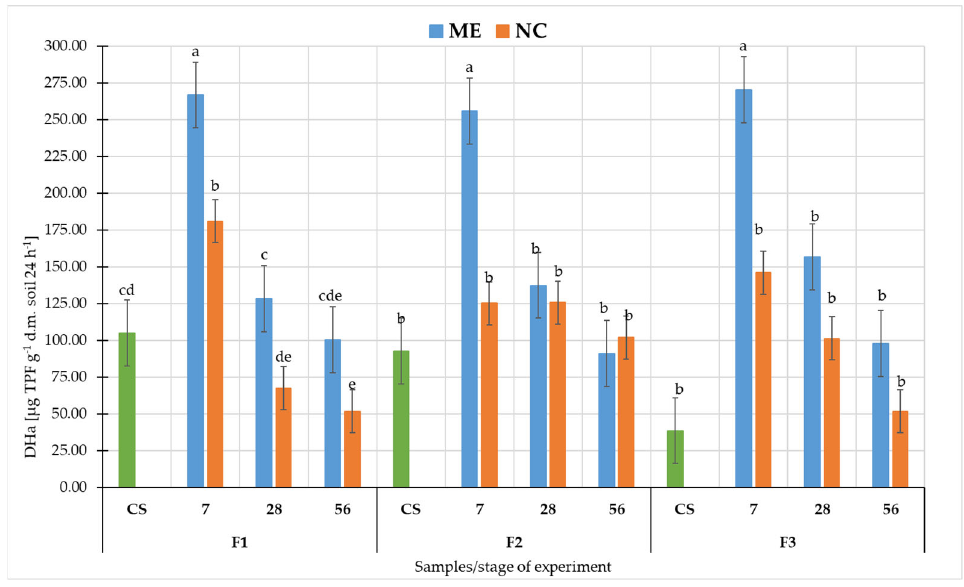
Figure 5. Activity of dehydrogenases (DHa) in fluvisol. Different lower-case letters “a–e” indicate significant differences for the same soil sample in different experimental variants (control, simulated flooding, natural flooding) at p < 0.05 (Tukey HSD test; n = 9). Explanation of the samples in Table 1. The overall trend of DHa activity in both NC and ME in all soils was as follows: in ‐ crease after 7 days of waterlogging (relative to CS), decrease after 28 and 56 days of flood ‐ ing.